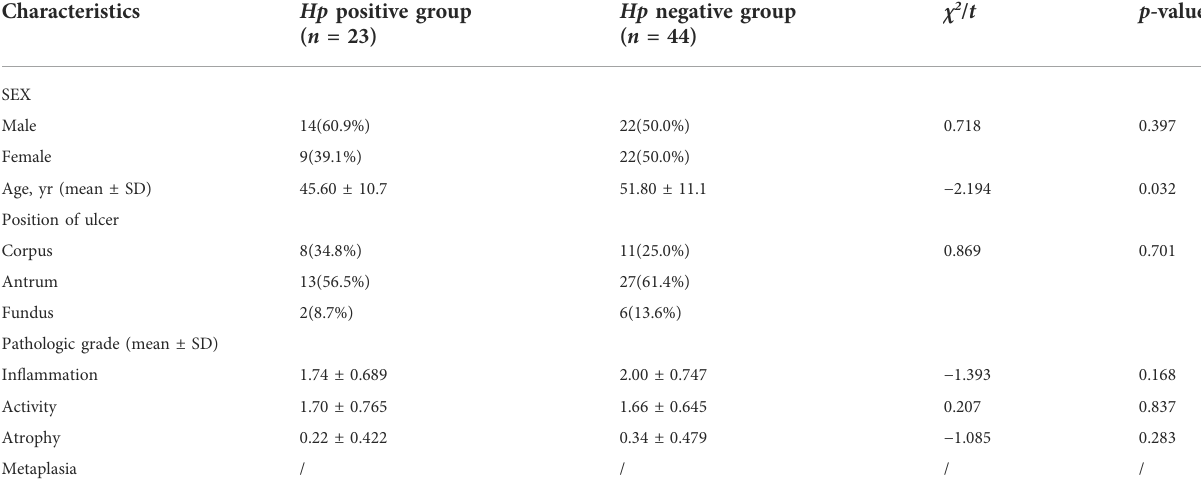
TABLE 1 Clinical characteristics of the patients enrolled in the study n (%).